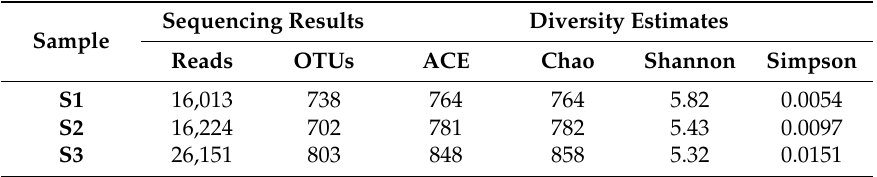
Table 3. MiSeq sequencing results and diversity estimates for each sample.